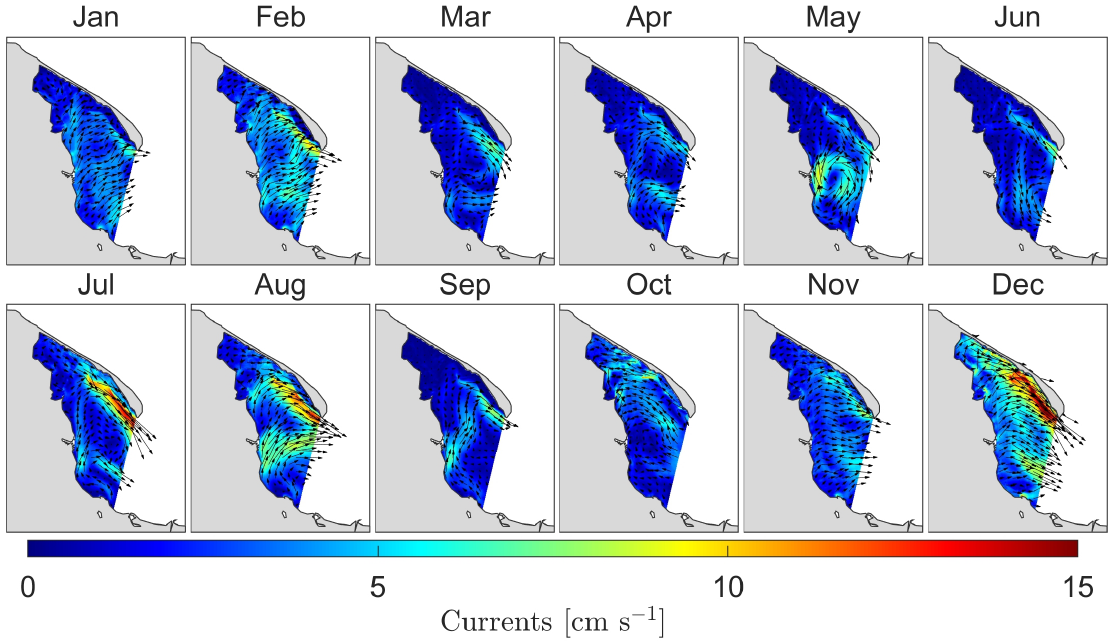
Figure 12. Monthly means of currents at sea surface